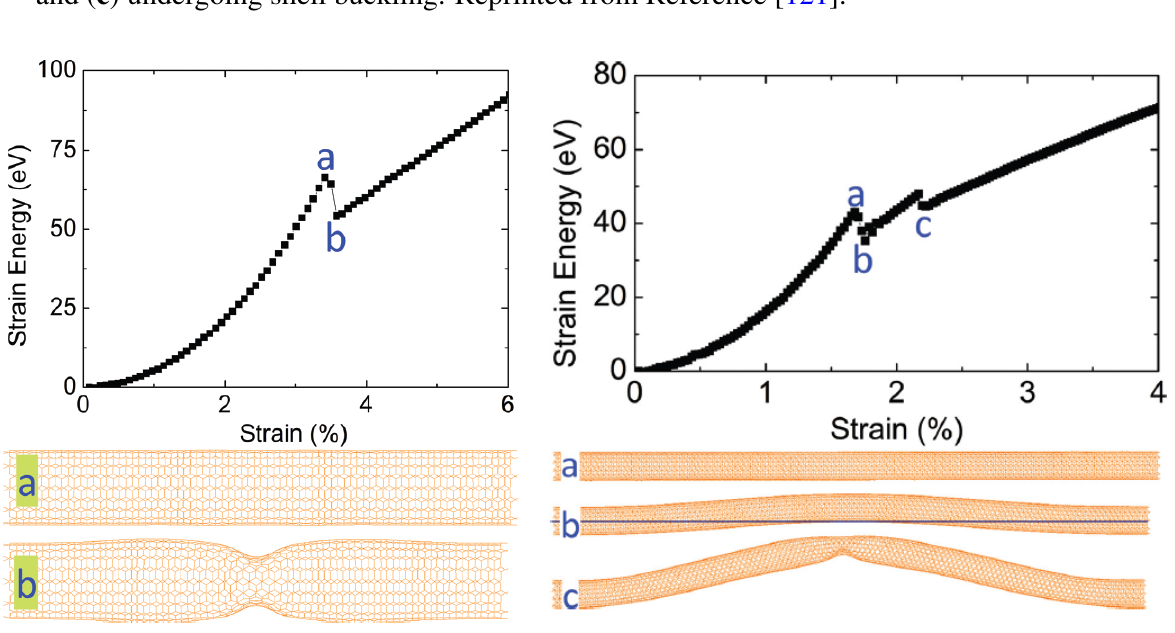
Figure 3. Axially buckled SWNT pattern deduced from molecular dynamics simulations. [Left] Upper panel: Energy-strain curve of a (10,10) SWNT with a length of 9.6 nm under axial compression. Lower panel: Typical tube geometry ( a ) before and ( b ) after buckling, respectively. [Right] Upper panel: Curve of a compressed (10,10) SWNT with 29.5 nm length. Lower panel: Snapshots of the tube ( a ) before buckling; ( b ) after column buckling; and ( c ) undergoing shell buckling. Reprinted from Reference